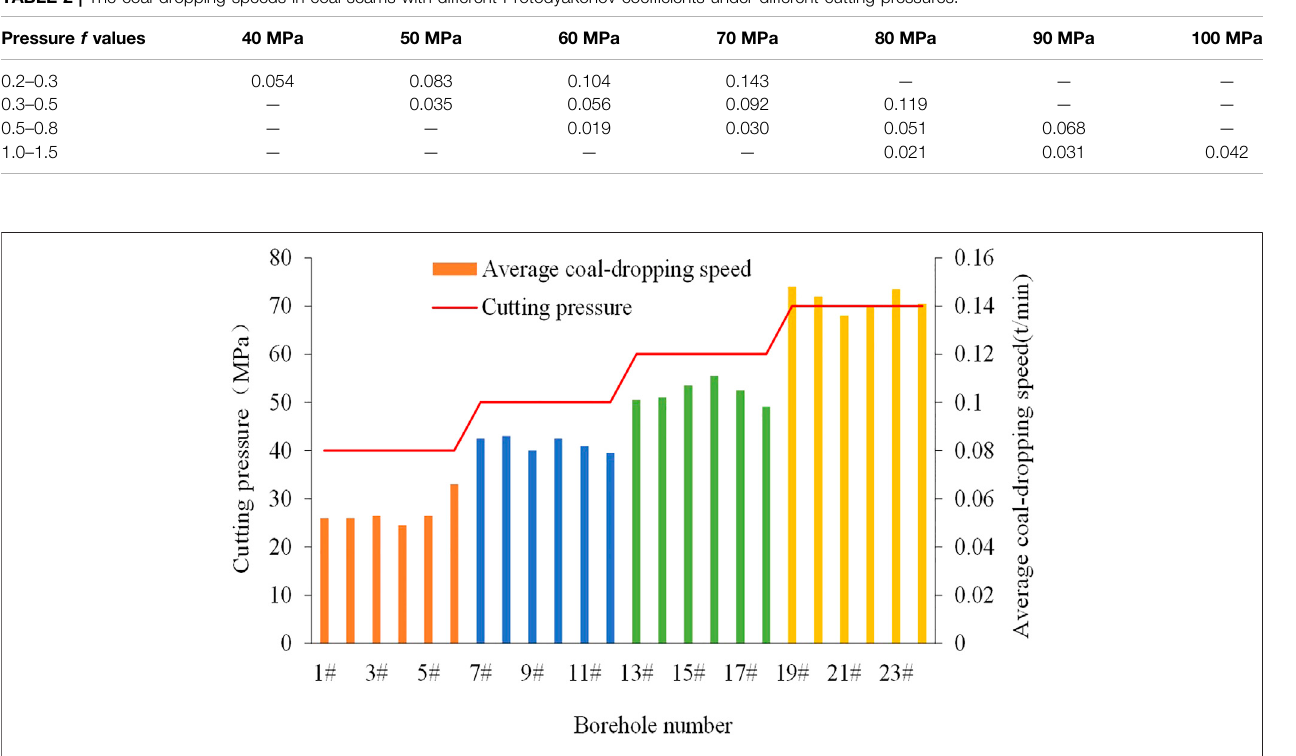
Frontiers in Earth Science |